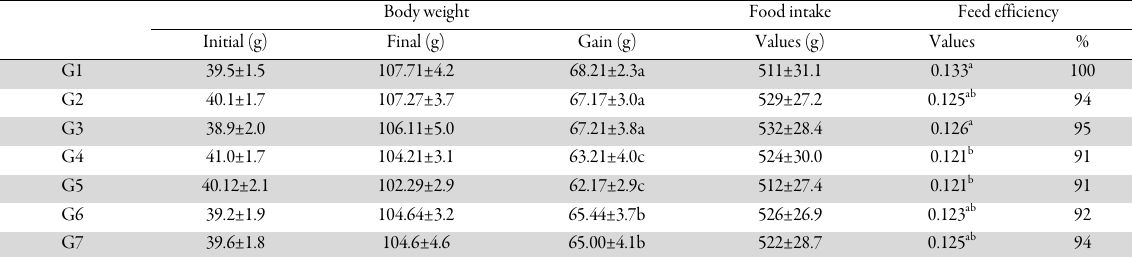
Table 2. Body weight gain, food intake and feed efficiency of healthy young rats treated with wheat colored biscuits